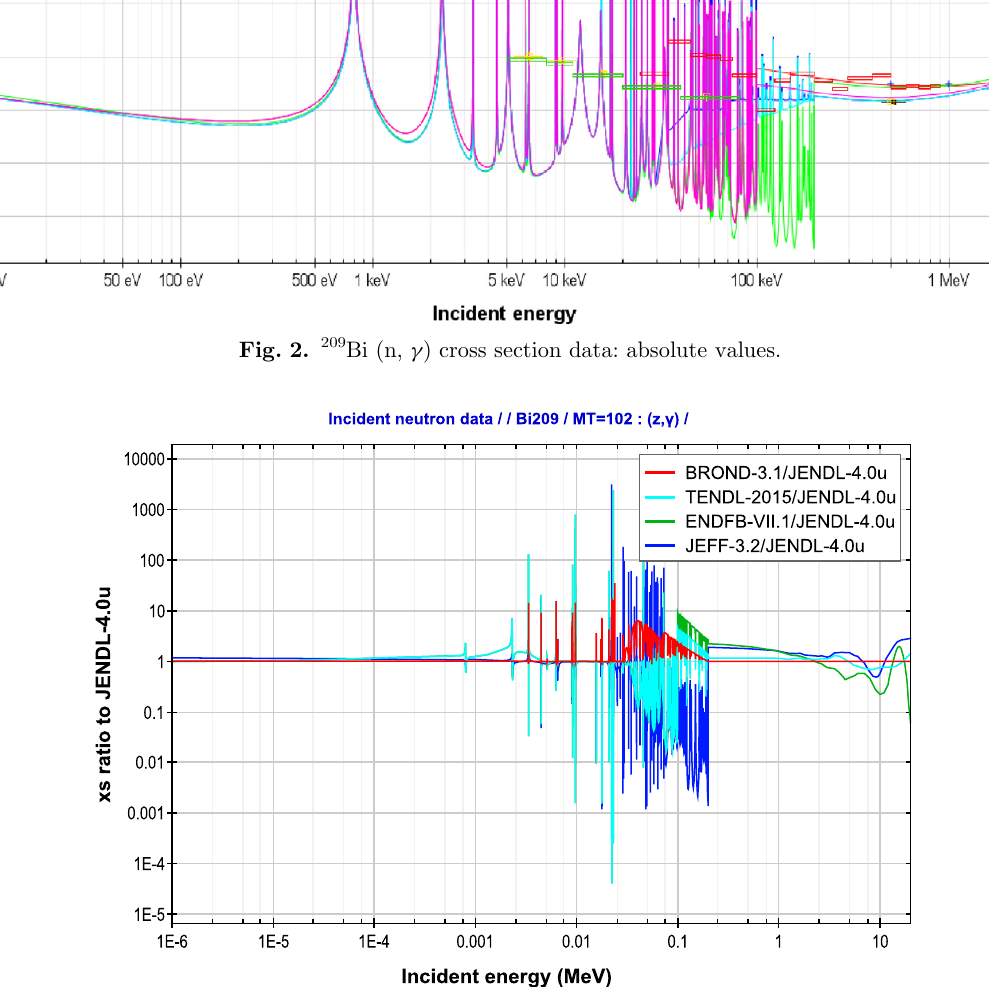
Fig. 3. 209 Bi (n, g ) cross section data: ratios to